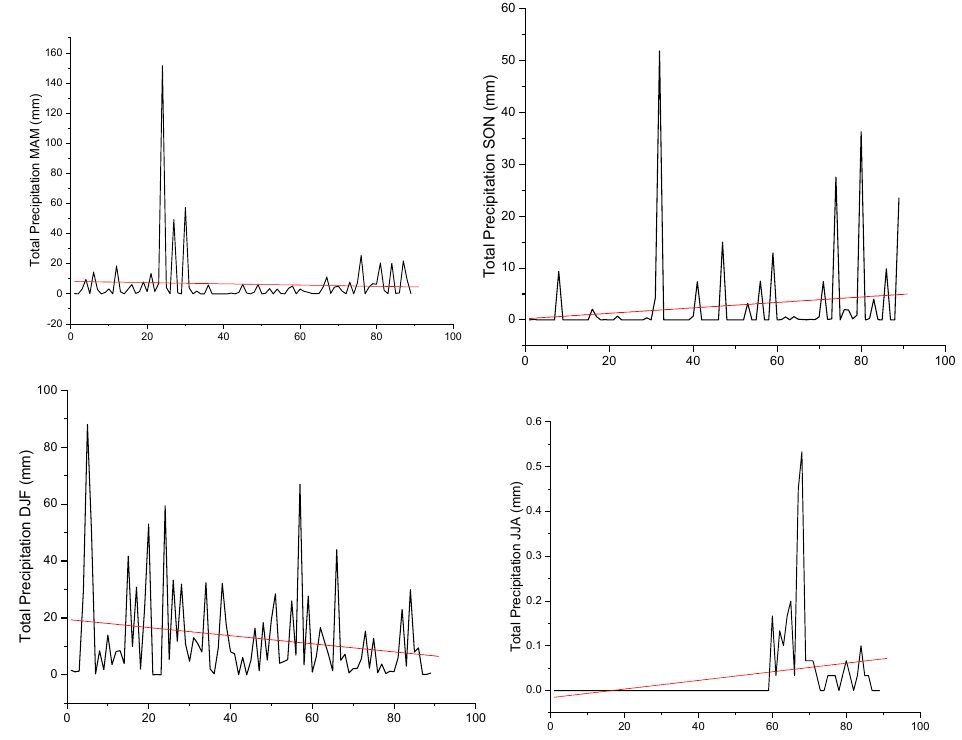
Figure 5. Average seasonal rainfall trends from 1987–2016. DJF = December, January February; MAM = March, April, May; JJA = June July August; SON = September, October, November). Data source QMD.